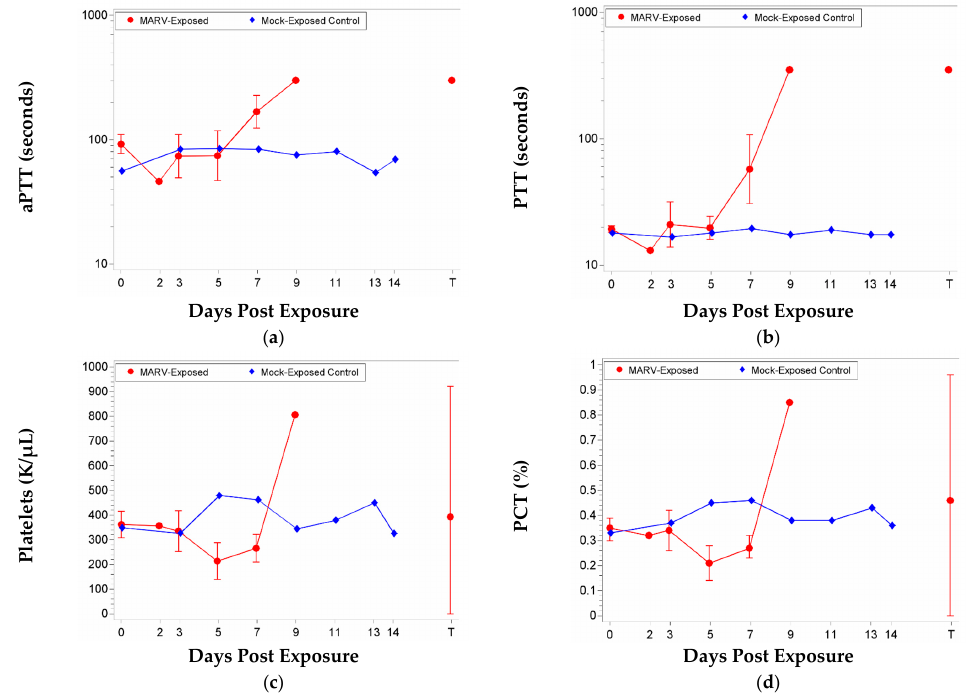
Figure 6. Mean with 95 percent confidence intervals over the course of the study for coagulation. Confidence interval was not plotted for sample size less than 3. For aPTT and PTT, values were log-transformed, and the geometric mean is displayed. For platelets and plateletcrit, values were not log-transformed, and the arithmetic mean is displayed. Terminal (T)—Terminal data collected from animals that met euthanasia criteria (unscheduled euthanasia) were combined and reported as a single time point. ( a ) aPTT; ( b ) PTT; ( c ) Platelets; ( d )